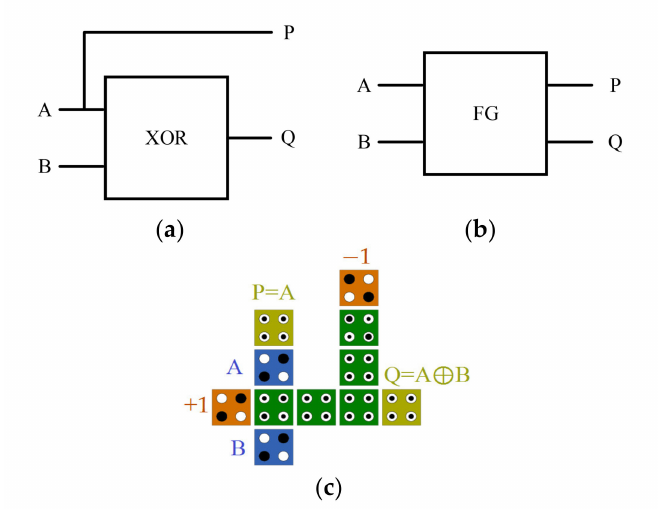
Figure 8. FG gate ( a ) logic diagram, ( b ) block diagram, and ( c ) QCA layout.